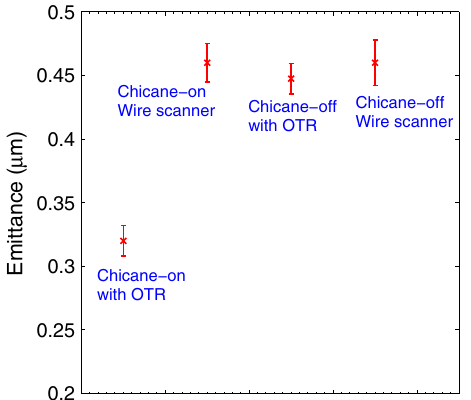
FIG. 3. Projected emittance measured at the 135 MeV point of the LCLS injector using the OTR screen and the wire scanner, for cases LH chicane on and off. The measured emittance ε close to ε . The beam charge is 150 pC and the peak current is yn about 50 A for the